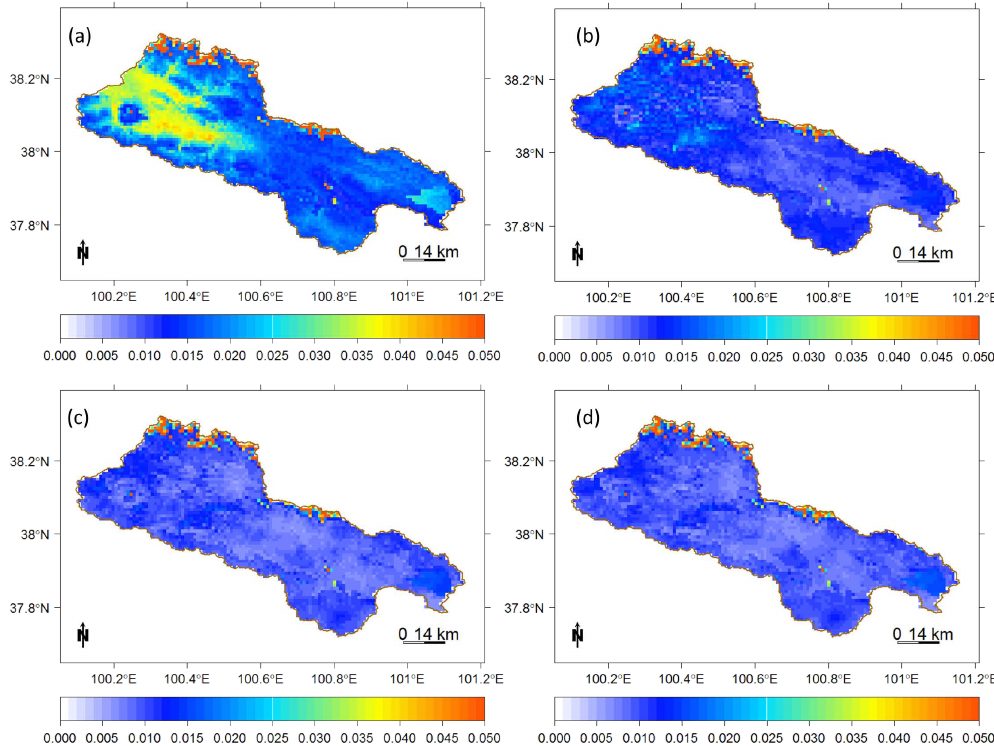
Fig. 9. This figure shows the basin scale 10 cm soil moisture RMSE values for open loop simulations (a) and three assimilation strategies of 1 observation used (1 Obs) (b) , 5 observations used (5 Obs) (c) and 9 observations used (9 Obs) (d) in case of 70% observational